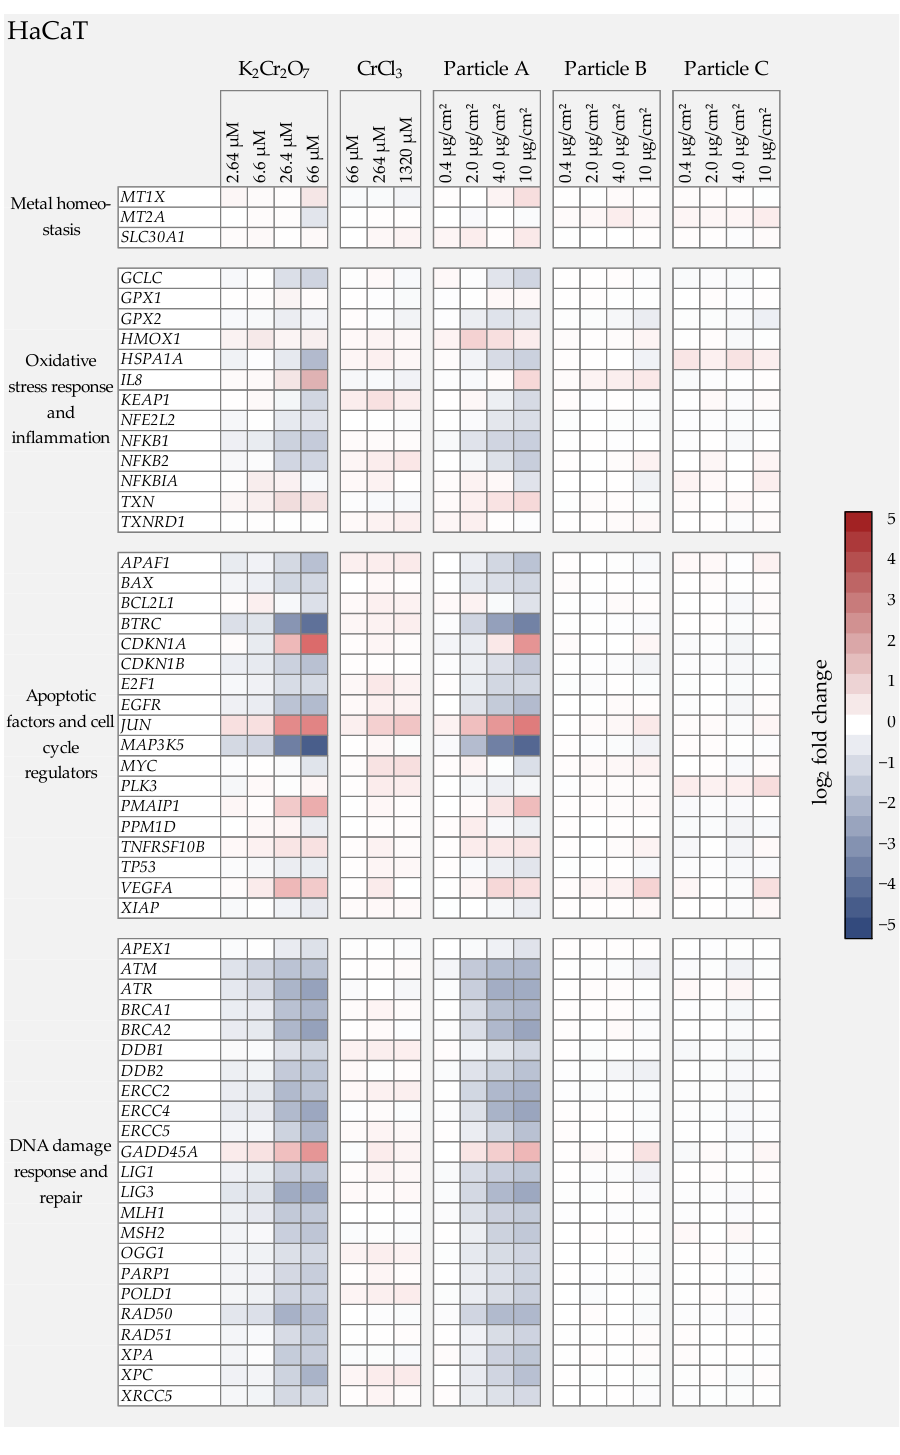
Figure 5. Overview of the impact of K 2 Cr 2 O 7 , CrCl 3 , or three different Cr(III) oxide particles on human keratinocytes (HaCaT) using a high-throughput RT-qPCR approach with a custom-designed gene set. The genes under investigation have been clustered into groups associated with metal homeostasis, oxidative stress response, inflammation, apoptosis, and cell cycle regulation as well as DNA damage response and repair. HaCaT cells were treated with the respective chromium compound for 24 h. Displayed are the log 2 fold changes of relative gene expression as a heatmap. Red colors indicate an enhanced expression, and blue colors indicate a down-regulation. The mean values of three independently conducted experiments are shown.